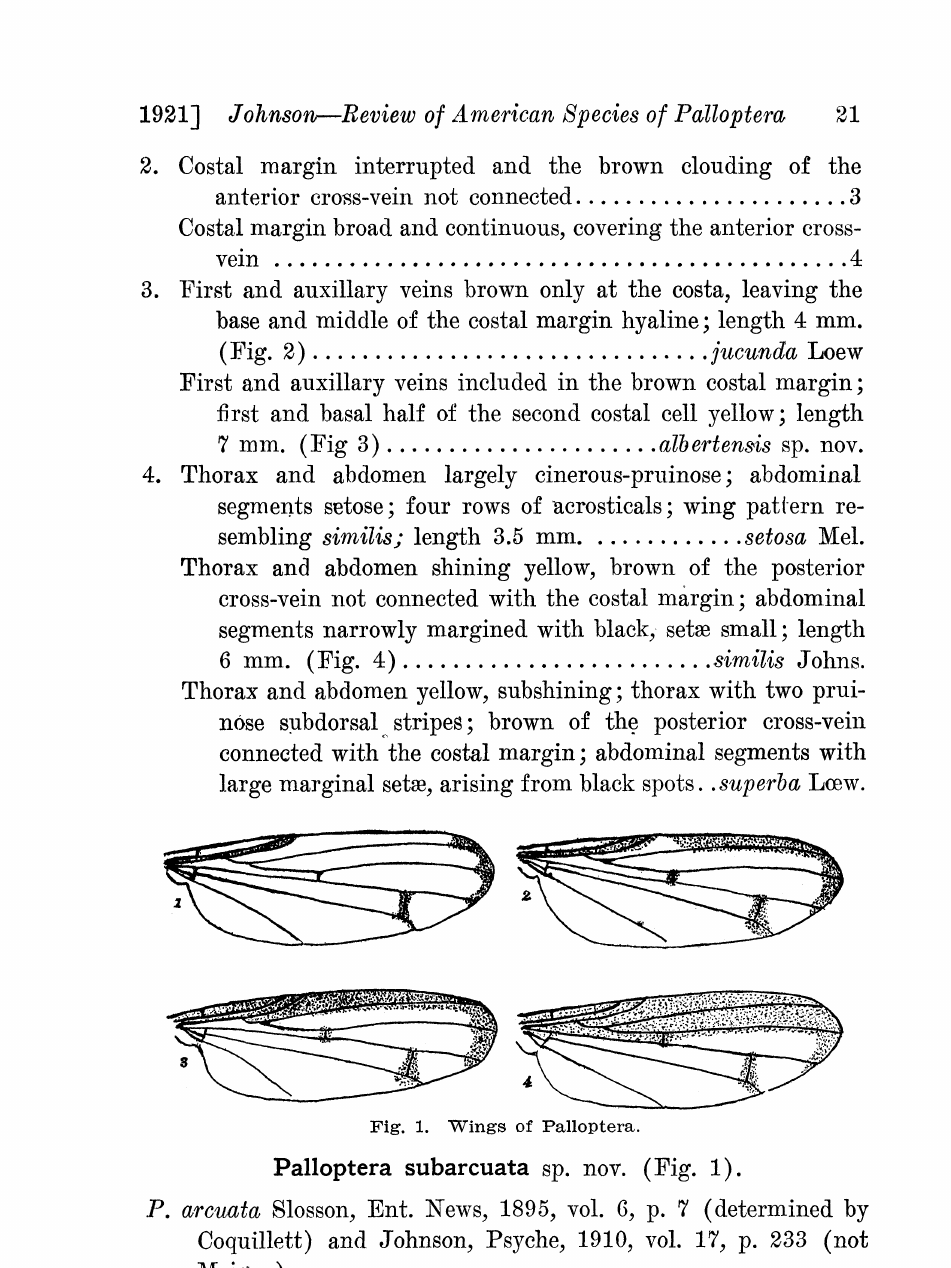
Fig. 1. q’ings of